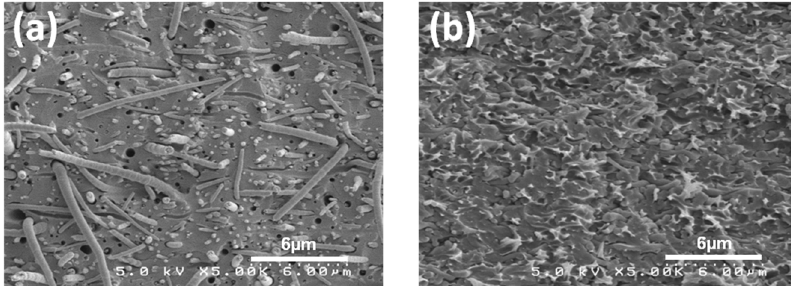
Figure 9. SEM micrographs of the cross-sections of two 57 vol% Nafion/PPSU membranes with complementary morphologies: ( a ) N/PPSU(fibers)–PPSU nanofibers embedded in a Nafion matrix; and ( b ) N(fibers)/PPSU–Nafion nanofibers embedded in a PPSU matrix. Magnification is 5,000X. Table 2. Transport properties of the two nanofiber composite membrane structures, with the same Nafion content. The measured properties of a Nafion 115 reference film are also listed. Permeability Ion Conductivity Diffusion Coefficient Structure (cm 2 /s) (mS/cm) (cm 2 /s)